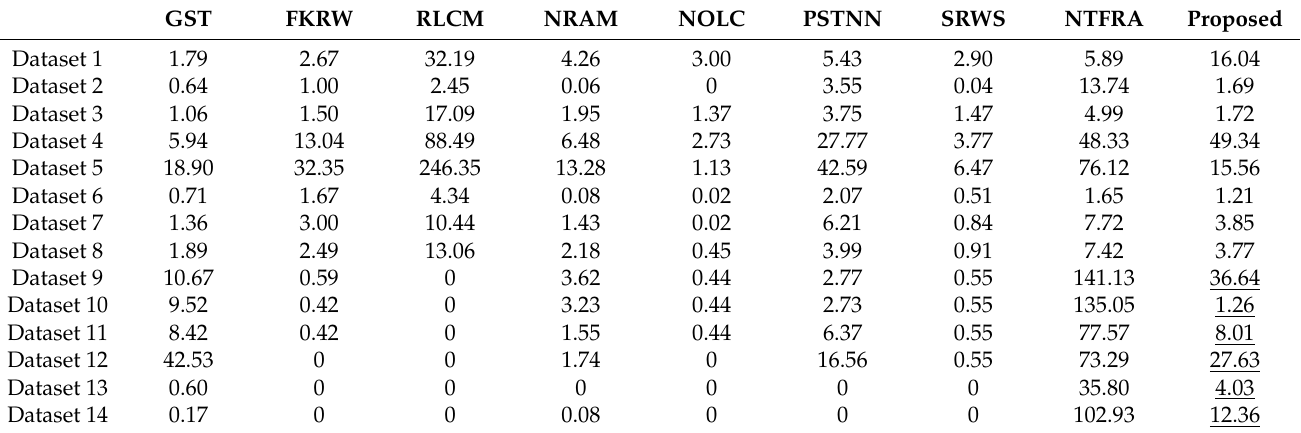
Table 8. Comparison of average SCRG between the proposed method and 8 traditional baseline methods in 14 sequence